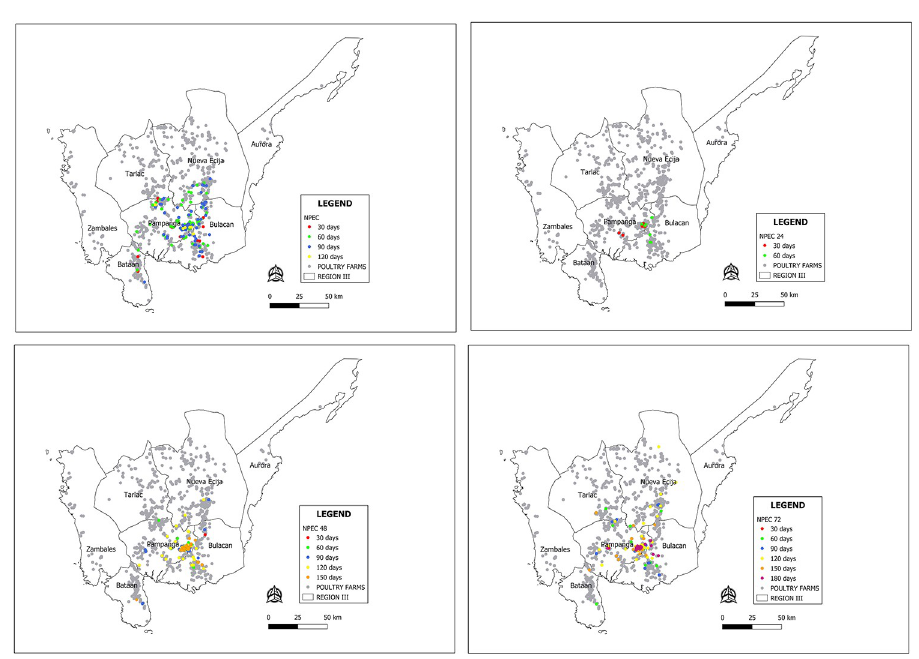
Fig 3. Comparison of the spatio-temporal progression of HPAI epidemic managed with no pre-emptive culling at various reporting period. Colored dots represent infected farms according to the duration of the epidemic.